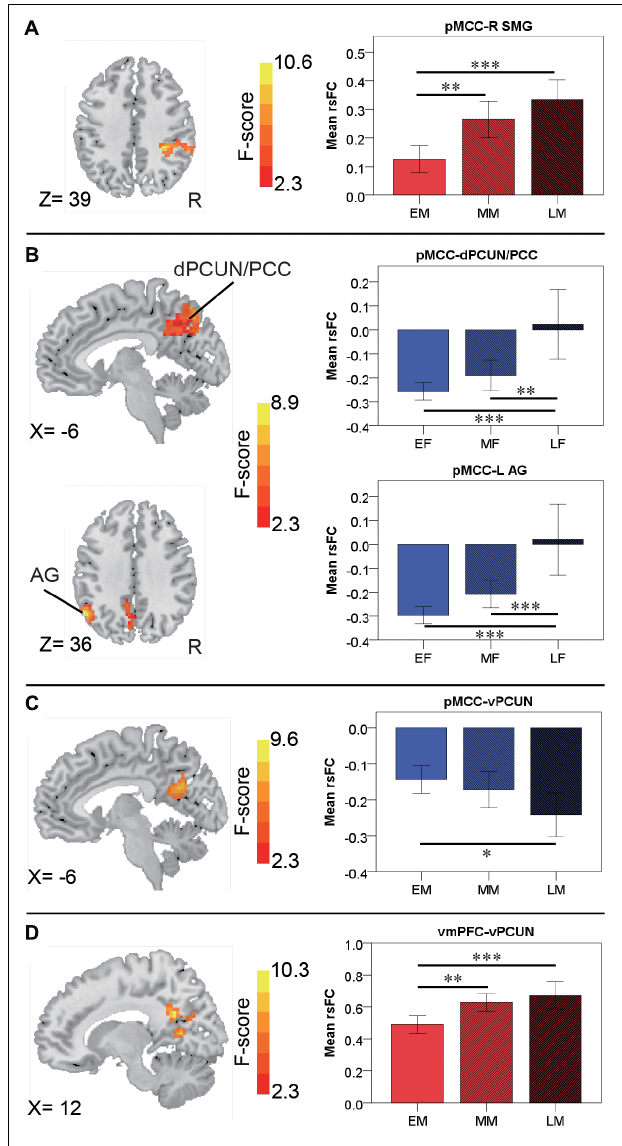
FIGURE 6 | Regions showing the age effect identified through ANCOVA (with a permutation test correction threshold of p < 0.05, and post hoc comparisons) in the pMCC(+) network in the males (A) , in the pMCC(–) network in the females (B) and in the males (C) , and in the vmPFC(+) network in the males (D) , each with the corresponding mean strength between the seed and region for the three different stages shown in the bar plot, error bars indicated two standard errors, and asterisks indicated significant differences with Bonferroni correction ( ∗ p < 0.05, ∗∗ p < 0.01, ∗∗∗ p < 0.001; pMCC, posterior midcingulate cortex; vmPFC, ventromedial prefrontal cortex; SMG, supramarginal gyrus; dPCUN, dorsal precuneus; PCC, posterior cingulate cortex; AG, angular gyrus; vPCUN, ventral precuneus; L, left; R,